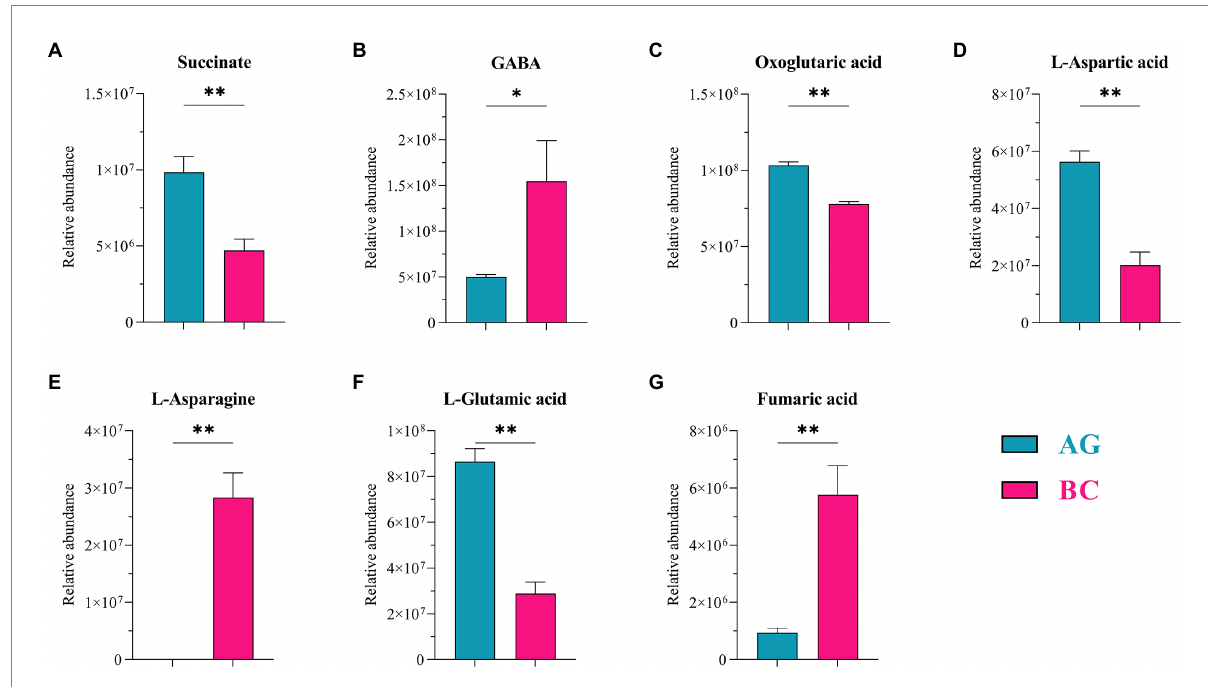
FIGURE 9 Metabolites in gut microbiota related to lipid metabolism between Xinjiang brown cattle (BC) and Angus cattle (AG). ( n = 5 in each breed). The bacterial metabolites related to lipid metabolism (A–G) . Values were expressed as means ± SEM. * denotes p < 0.05 indicating significant difference, ** denotes p < 0.01 indicating extremely significant